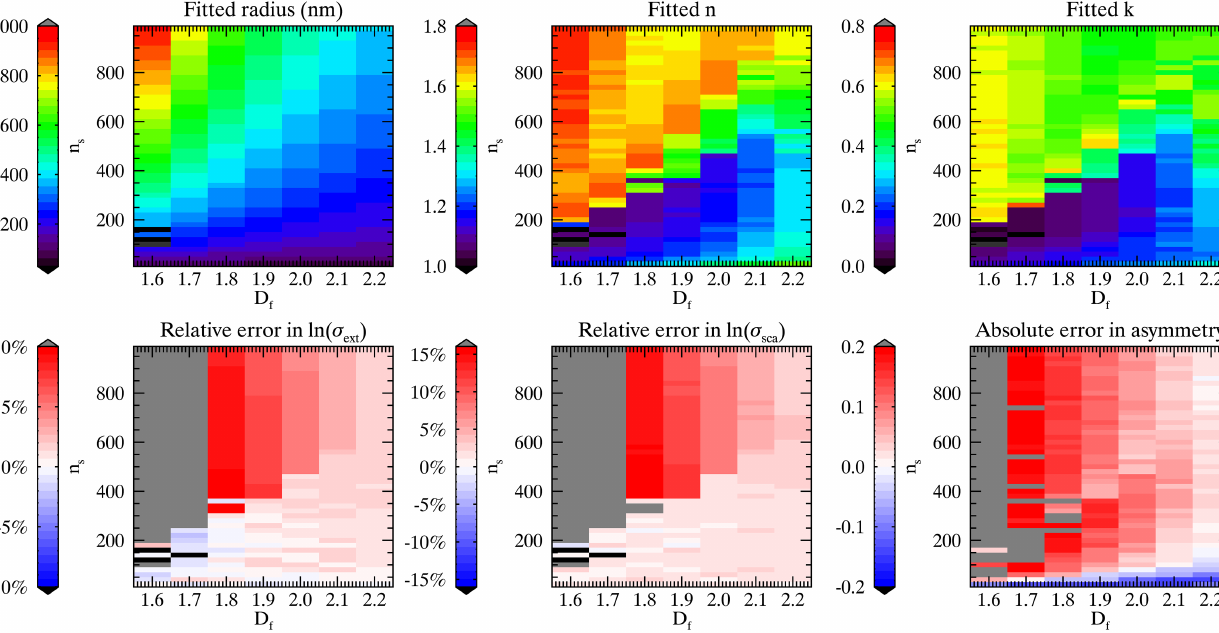
Figure 8. The optimum fitted sphere parameters ( r , n , and k ) and their resultant errors relative to the reference MSTM calculations in ln σ ext and ln σ sca , and absolute errors in g for BCFAs with λ = 550nm. The colour scale has been adjusted so that the very large errors caused by unphysically small BCFA D f are